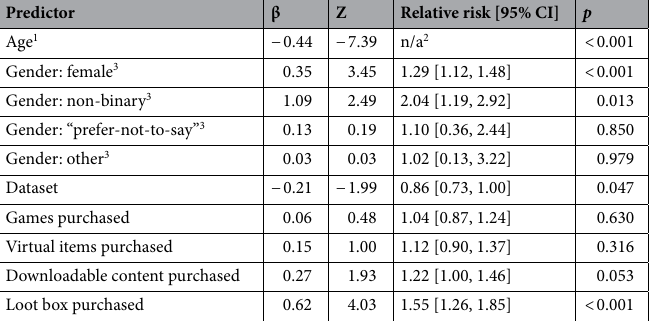
Table 2. Binomial linear regression results including all forms of measured game spending as factors, with age as a covariate, and gender and dataset as factors. 1 Age converted to Z-score to generate β. 2 Relative risk inappropriate for age as a continuous covariate. 3 Comparison group: male.